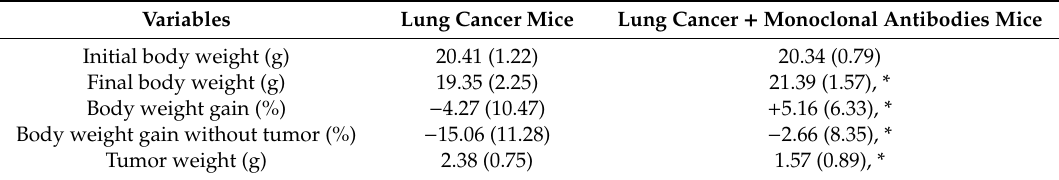
Table 2. Physiological and tumor characteristics in the study groups of